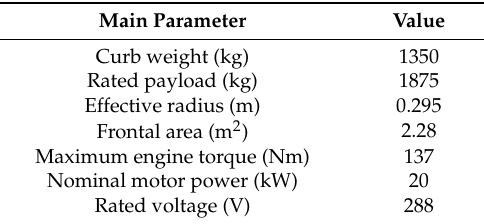
Table 12. Specifications of the prototype